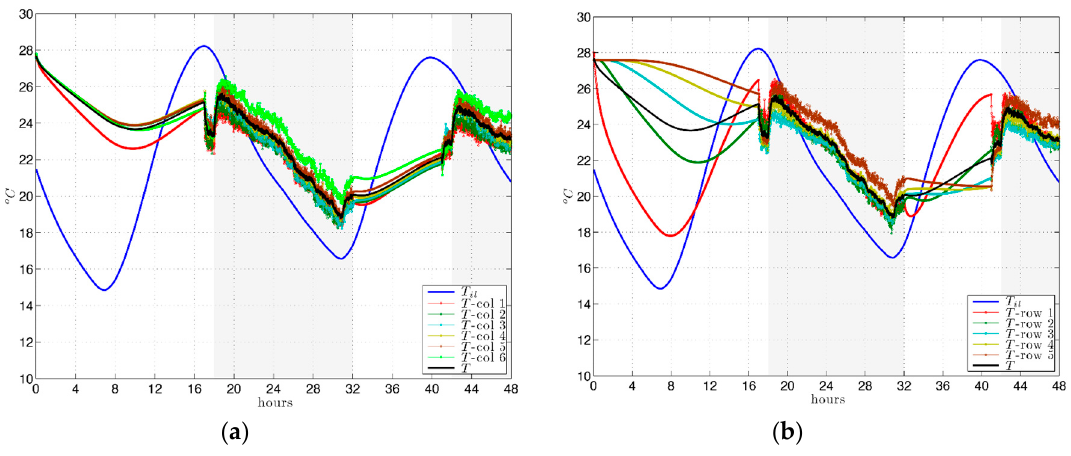
Figure 13. Case 2: Efficient energy proposal. Summer. Internal layer temperature T il and averaged room temperature T together with calculated indoor temperatures at the probe points given in Figure 4. ( a ) by columns; ( b ) by rows.